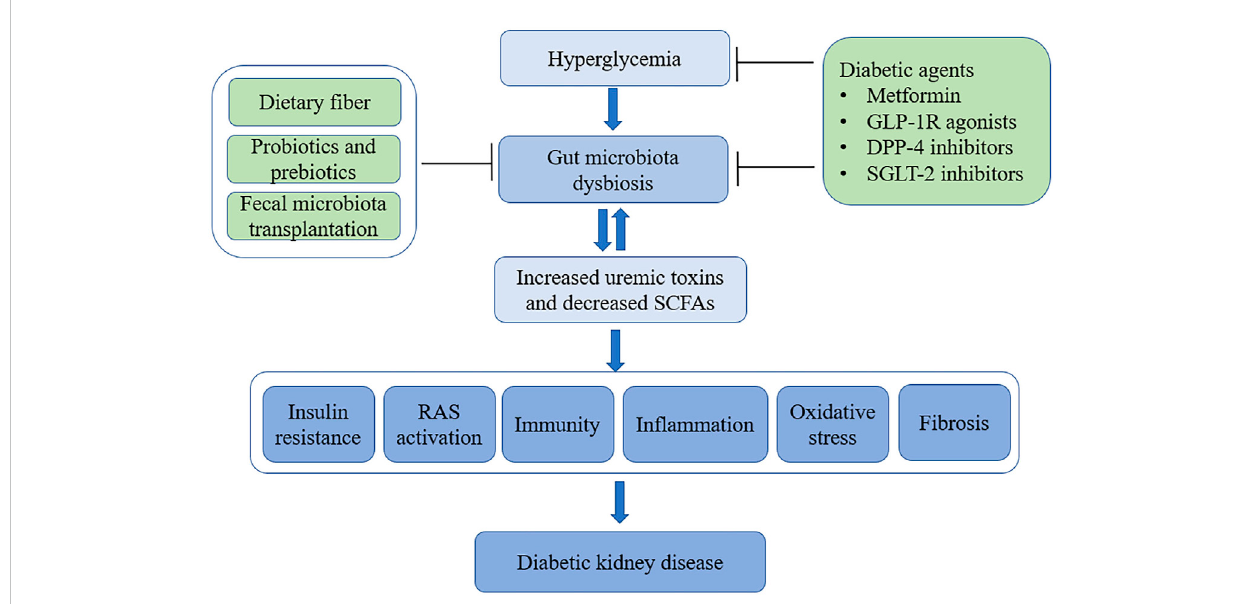
FIGURE 2 The gut-kidney axis in the pathogenesis of DKD and application of gut microbiota-targeted therapies. In patients with diabetes, hyperglycemia promotes gut microbiota dysbiosis, which contributes to the development of DKD. Gut microbiota-targeted therapies including dietary fi ber, supplementationwithprobioticsorprebiotics,fecalmicrobiotatransplantationanddiabeticagentsthatmodulatethegutmicrobiota,suchasmetformin, GLP-1Ragonists,DPP-4inhibitors,andSGLT-2inhibitors.(DKD,diabetickidneydisease;SCFAs,short-chainfattyacids;RAS,renalrenin-angiotensin system; GLP-1, glucagon-like peptide-1 receptor; DPP-4, dipeptidyl peptidase-4; SGLT-2, sodium-glucose cotransporter